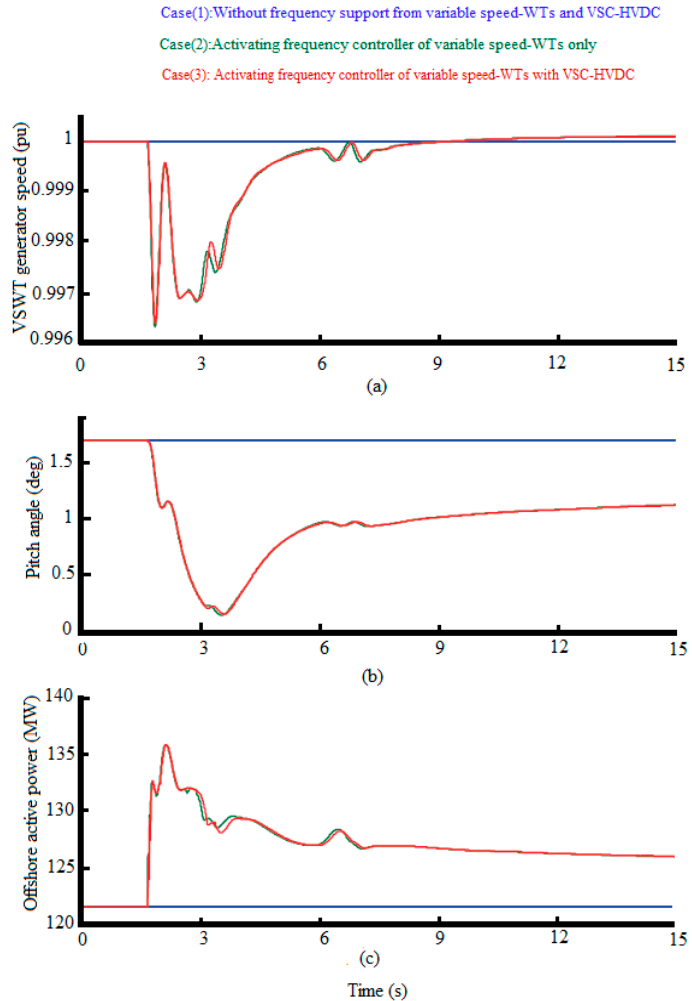
Figure 23. Effect of the frequency regulation in the three cases for; ( a ) speed of wind turbine generator; ( b ) pitch angle; ( c ) offshore active power production.